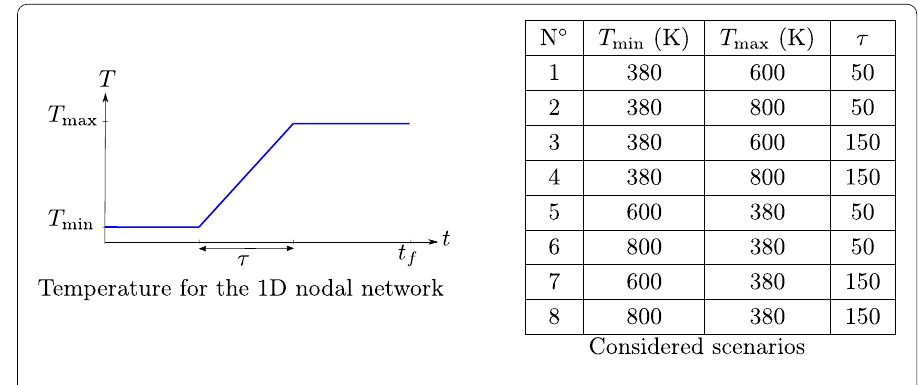
Fig. 6 Definition and description of the considered scenarios